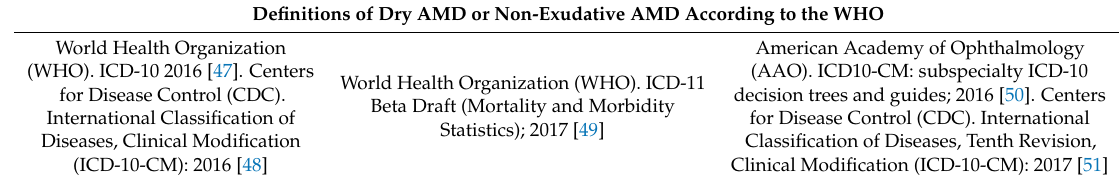
Table 2. Definitions of dry age-related macular degeneration (AMD) or non-exudative AMD in the international classification of diseases (ICD), and clinical modification (CM) according to the World Health Organization